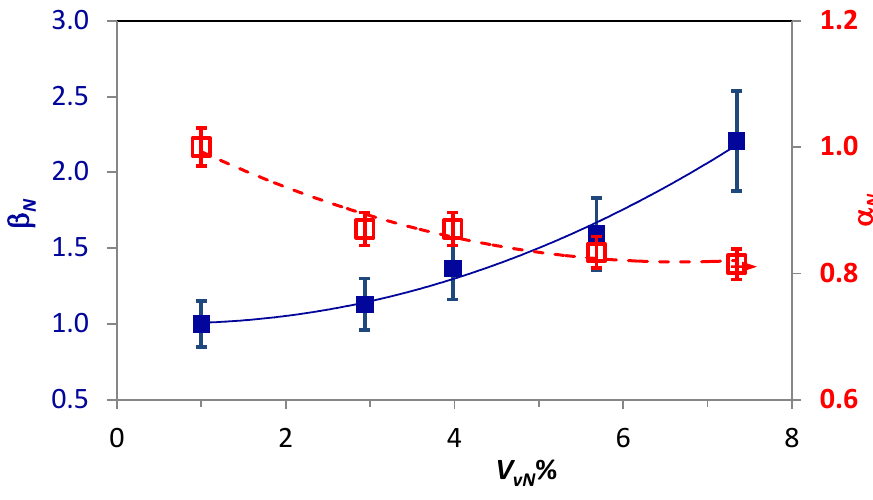
Figure 11. Comparison between ultrasonic attenuation and thermal diffusivity for the Pu coupons type. The results related to ultrasonic attenuation, β the left axis, and the ones related to thermal diffusivity, right